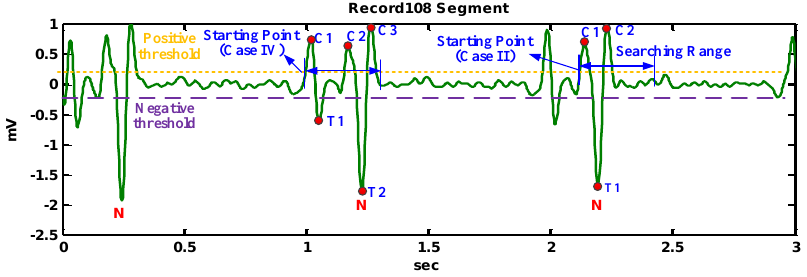
Figure 9. The demonstration of QRS fiducial point detection for the Record 108 segment.